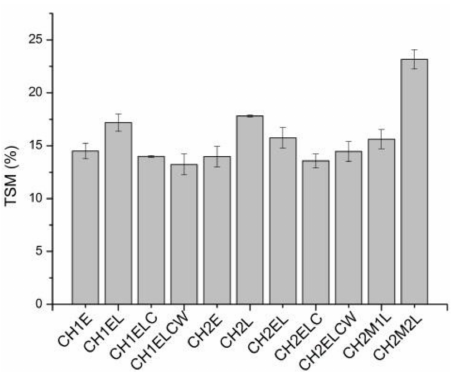
Figure 3. Total soluble matter (TSM) for chitosan/starch-based